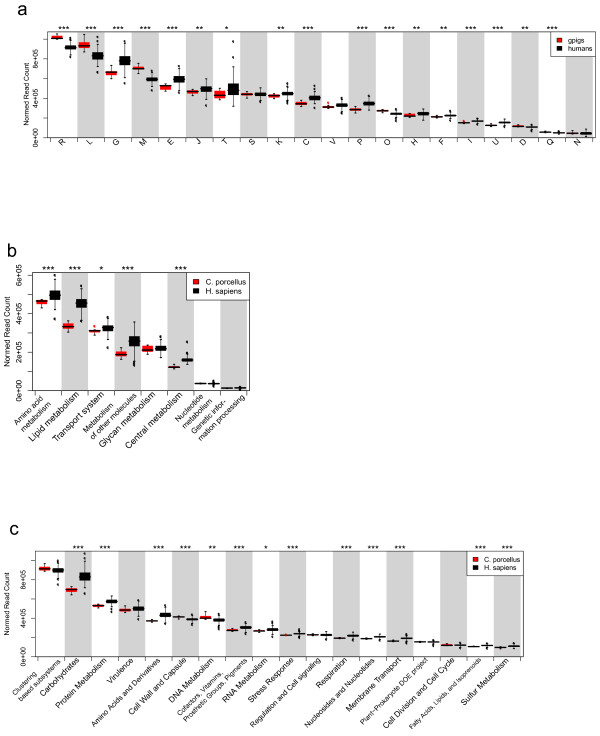
Functional categories. Normalized read counts of functional categories from a) COG categories b) KEGG subcategories and c) SEED families, respectively. Asterisks denote significant differences in abundance, * : q-value < 0.1, ** : q-value < 0.05 and *** : q-value < 0.01. COG categories are named as follows: A: RNA processing and modification, B: Chromatin Structure and dynamics, C: Energy production and conversion, D: Cell cycle control and mitosis, E: Amino Acid metabolism and transport, F: Nucleotide metabolism and transport, G: Carbohydrate metabolism and transport, H: Coenzyme metabolism, I: Lipid metabolism, J: Translation, K: Transcription, L: Replication and repair, M: Cell wall/membrane/envelop biogenesis, N: Cell motility, O: Post-translational modification, protein turnover, chaperone functions, P: Inorganic ion transport and metabolism, Q: Secondary Structure, T: Signal Transduction, U: Intracellular trafficking and secretion, Y: Nuclear structure, Z: Cytoskeleton, R: General Functional Prediction only, S: Function Unknown.